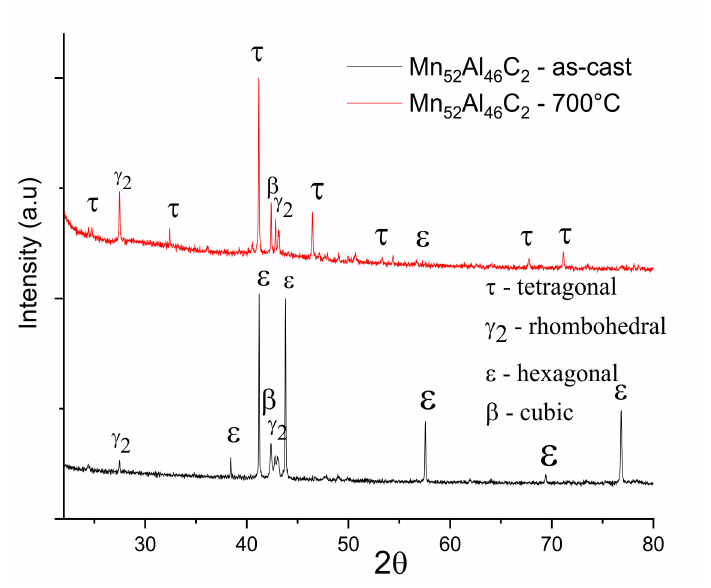
Figure 3. X-ray diffractograms for samples Mn 53 Al 45 C 2 as-cast and annealed at 700 ◦ C.